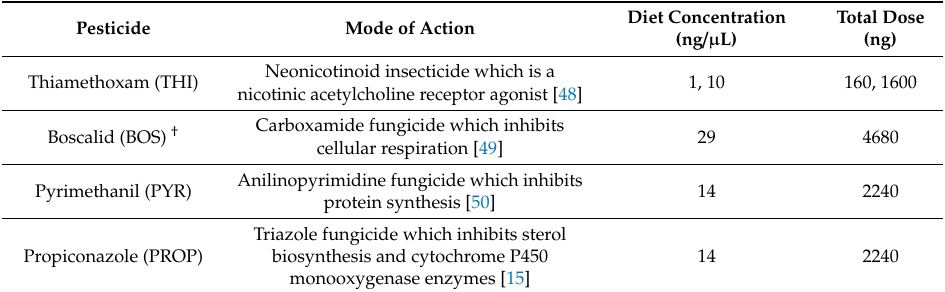
Table 2. Pesticides, mode of action, concentration and total dose in 160 µ L larval diet, provided from day 0 to day 5, to honeybee worker larvae reared in vitro . Pesticide Mode of Action